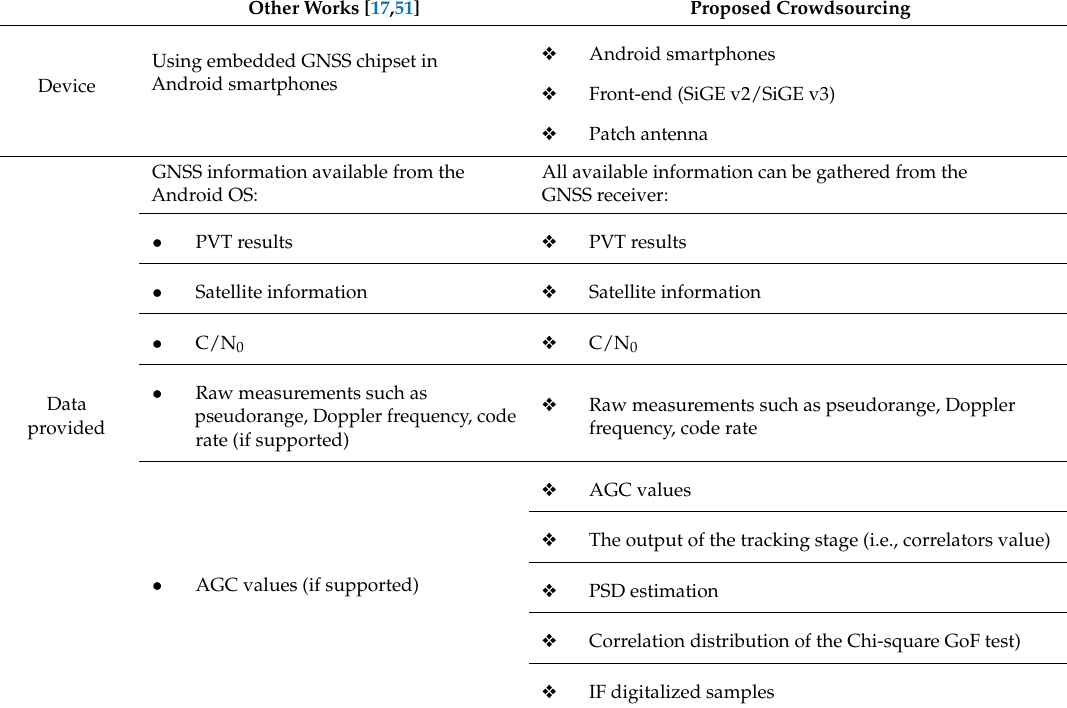
Table 2. Comparison between similar works and the proposed crowdsourcing